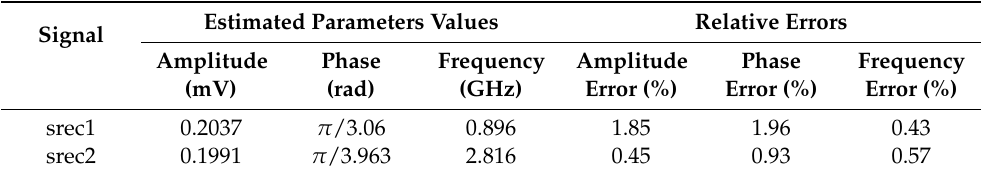
Table 3. Comparison between estimated parameters and the real ones. Signal